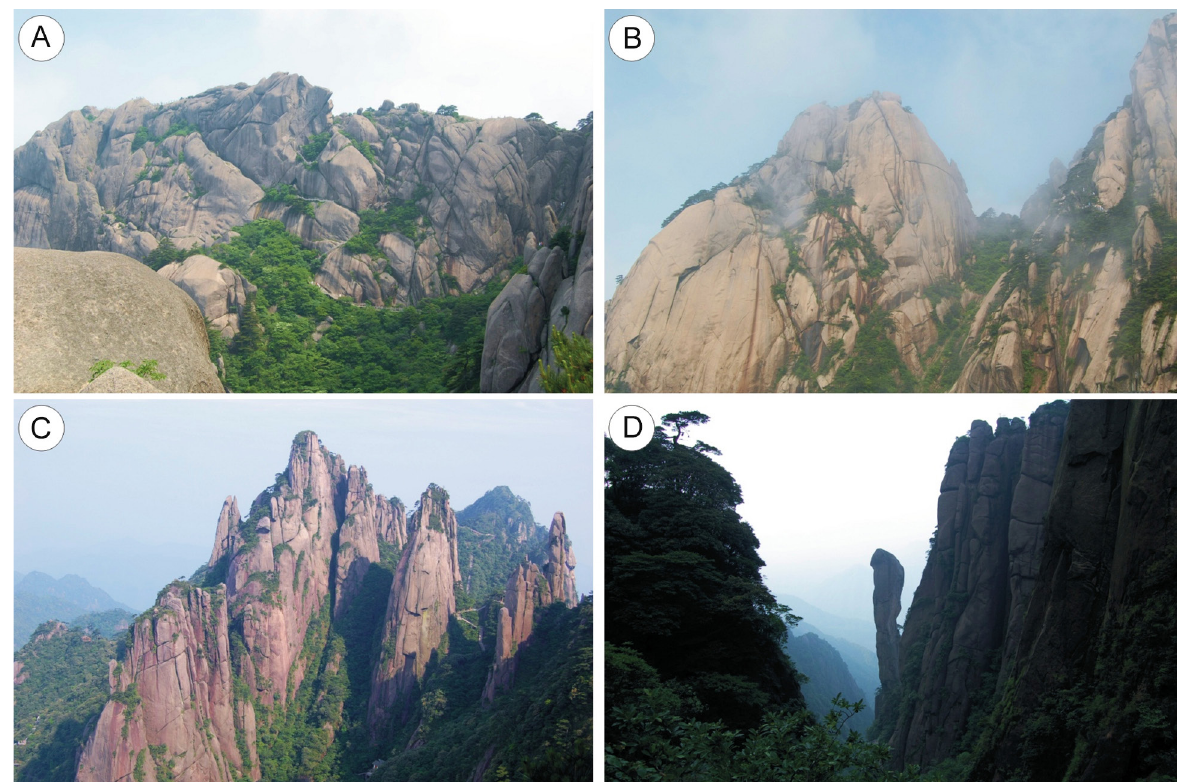
Fig. 2. Geomorphic features of Huangshan (A, B) and Sanqingshan (C, D) (Photos P. Migoń). A – inner part of Huangshan, B – massive domes in the peripheral part of the mountain-top surface, C – rock relief dominated by vertical joints, D – deeply incised ravines, with the Giant Boa rock residual in the middle of the